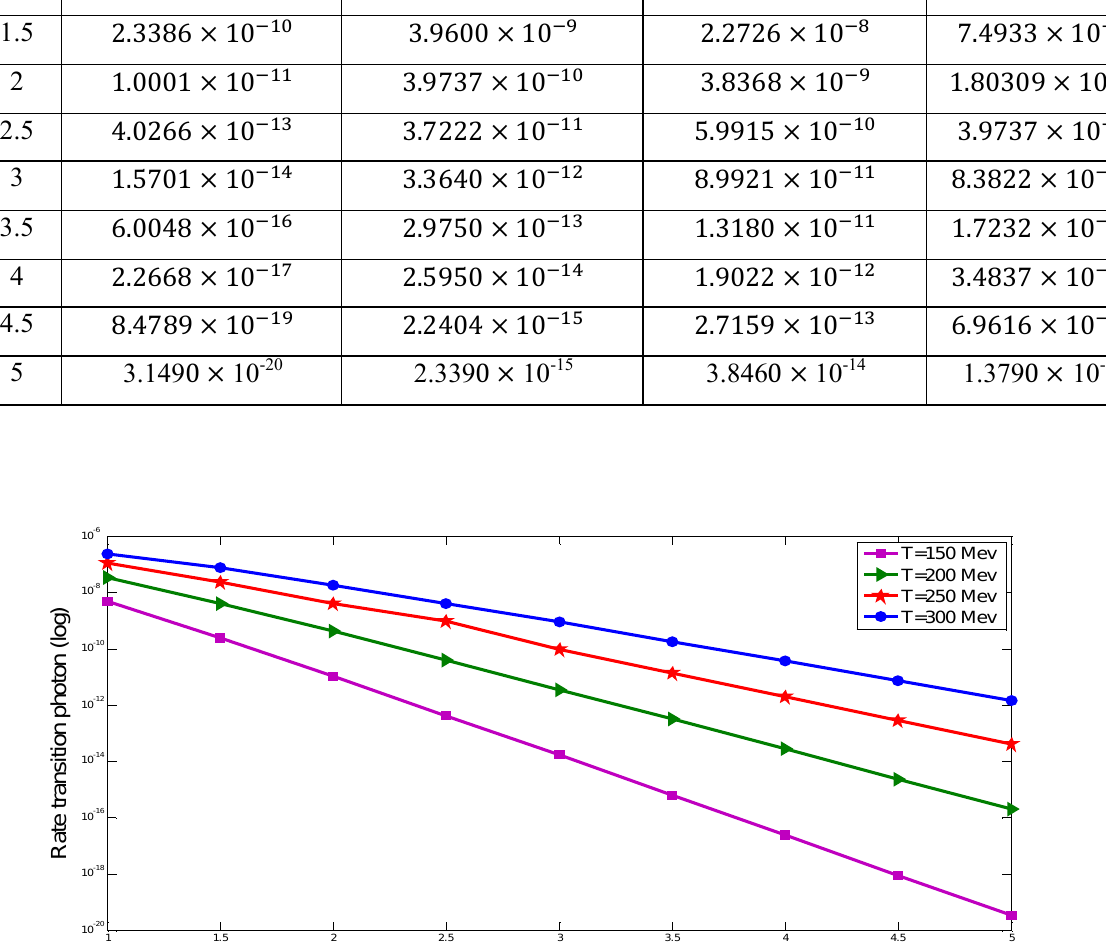
(cid:3435)(cid:2235) , (cid:2176), (cid:2161) (cid:3439) as a function of (cid:2161) (cid:2159)(cid:2197)(cid:2195)(cid:2198)(cid:2202)(cid:2197)(cid:2196) (cid:2187)(cid:2201)(cid:2185) (cid:2198)(cid:2190)(cid:2197)(cid:2202)(cid:2197)(cid:2196) (cid:2782) = 160 , (cid:2176) (cid:2185) (cid:2786)